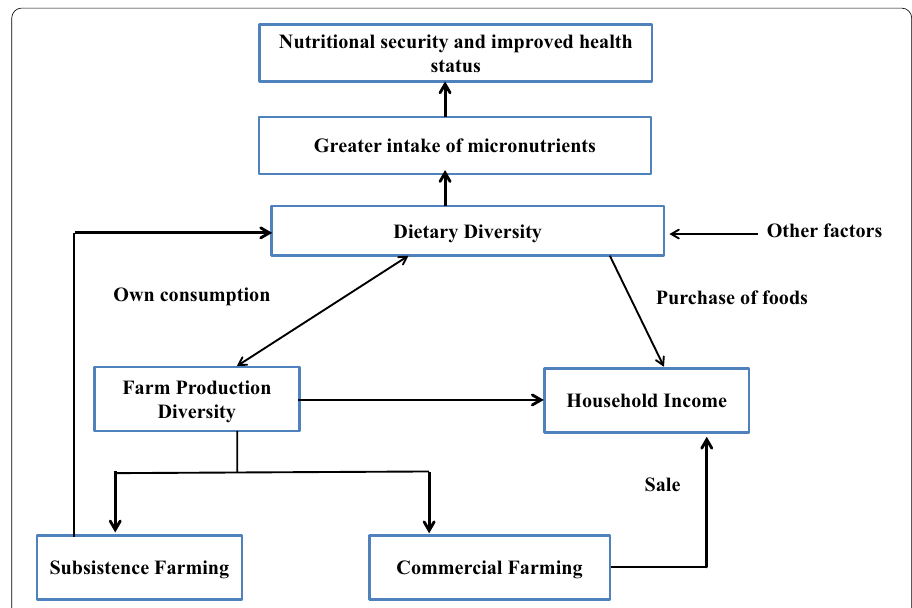
Fig. 1 Conceptual framework displaying the associations among farm production diversity, income and dietary diversity (Authors’ construction based on Bellon et al.